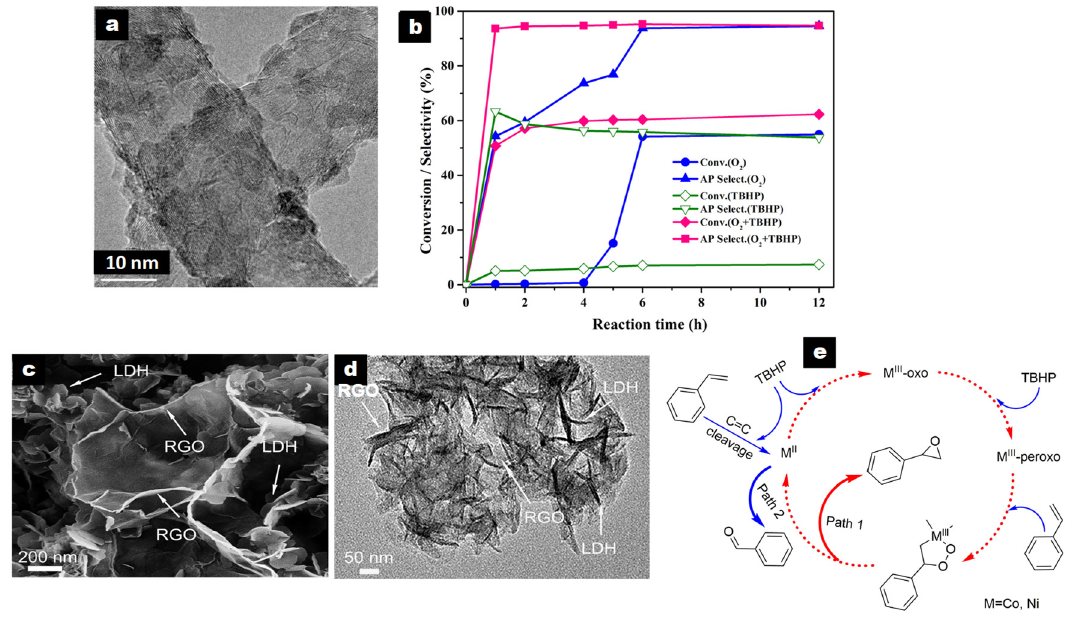
Figure 3. ( a ) HRTEM image of ZnCr-LDH/CNT composite; ( b ) ZnCr-LDH/CNT performance with single molecular oxygen, single TBHP (0.5 mL, 70% aqueous solution), and mixed oxidants of O 2 and TBHP, respectively (reaction conditions: EB, 10 mL; P O2 , 1.0 MPa; 130 °C; catalyst, 0.1 g). Reproduced with permission [62]. Copyright 2018, Elsevier. ( c , d ) SEM and TEM images of NiCo-LDH/RGO 5 and ( e ) proposed reaction pathway for the epoxidation for styrene. Reproduced with permission [63]. Copyright 2019, Elsevier.